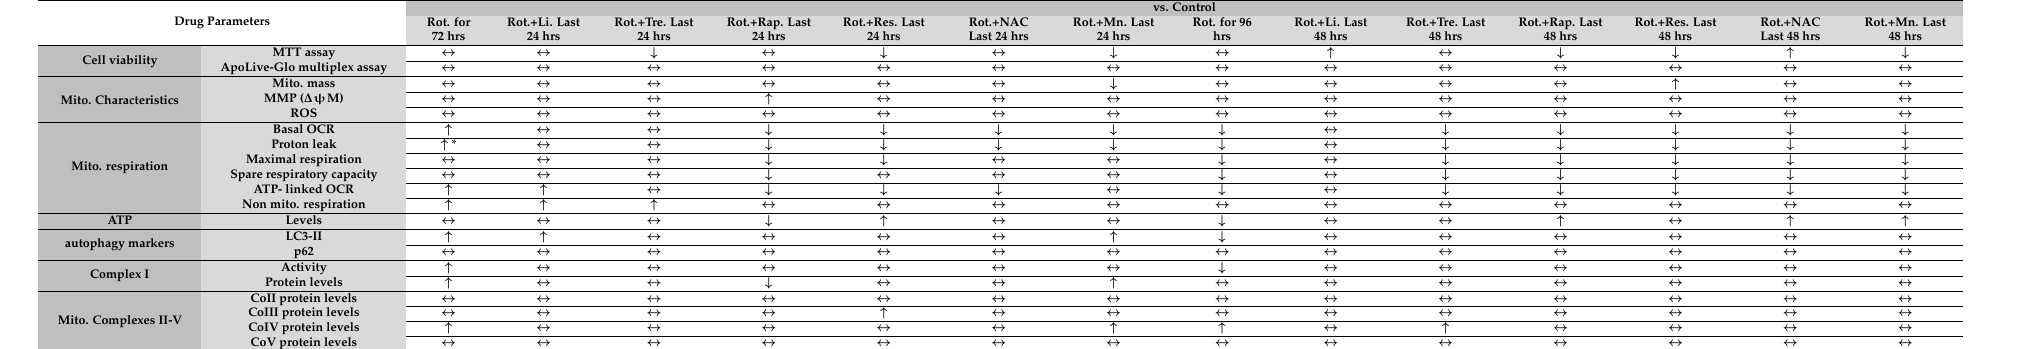
Table 2. A qualitative summary of the interaction between the effects of rotenone and ROS scavengers/ autophagy enhancers.